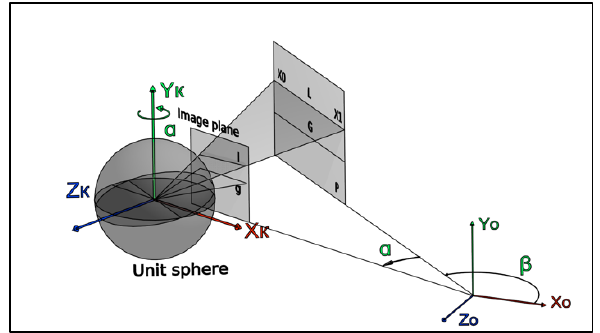
Figure 2. MLZ rotation estimation for a case when line L is coplanar to plane О c Х c Z c